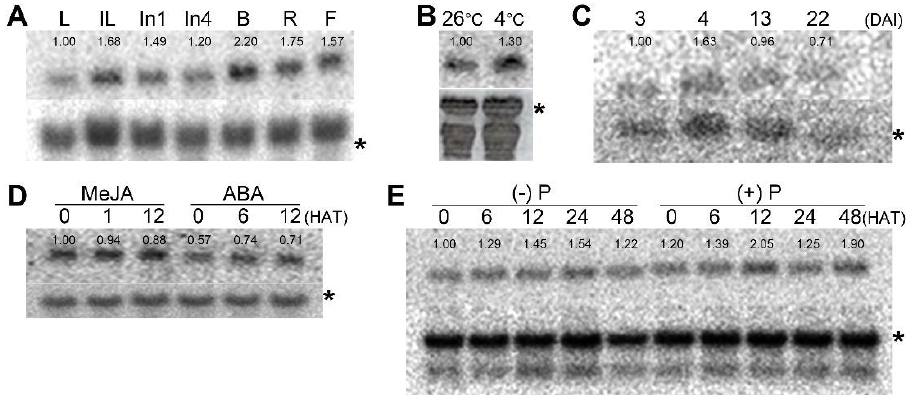
Figure 7. Sugarcane ScRpb4 gene expression. ( A ) Expression of ScRpb4 in different tissues: mature leaf (L), immature leaf (IL), first (lowest) internode (In1), fourth internode (In4), lateral bud (B), root (R), flower (F). ( B ) Expression of ScRpb4 in response to low temperatures. Plants were maintained for 24 h at 26 °C under control conditions and low temperatures 4 °C for 24 h. ( C ) Expression of ScRpb4 during lateral bud development at 3, 4, 13, and 22 days after imbibition in water. ( D ) Expression of ScRpb4 in response to methyl jasmonate (MeJA) and abscisic acid (ABA) for 48 h. ( E ) ScRpb4 expression in roots in response to phosphorus deprivation (− P) or normal conditions (+P) for 48 h. The numbers above each lane indicate the relative intensity of the hybridization signal. Asterisk indicates rRNA as an internal control. DAI, days after imbibition; HAT, hours after treatment.